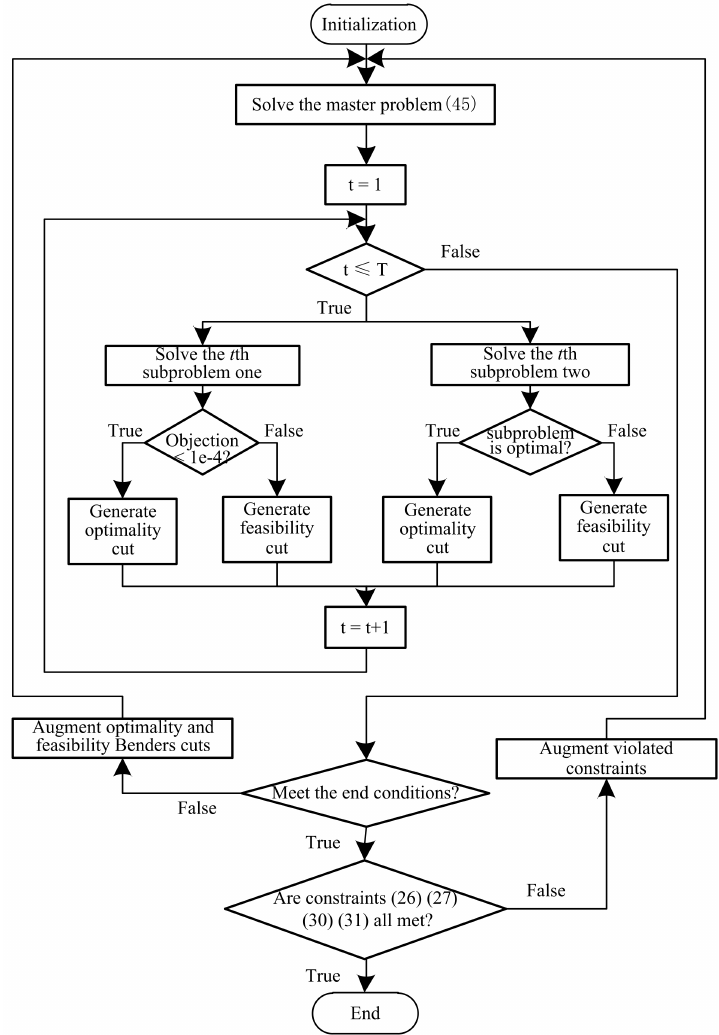
Figure 1. Flow chart of the proposed